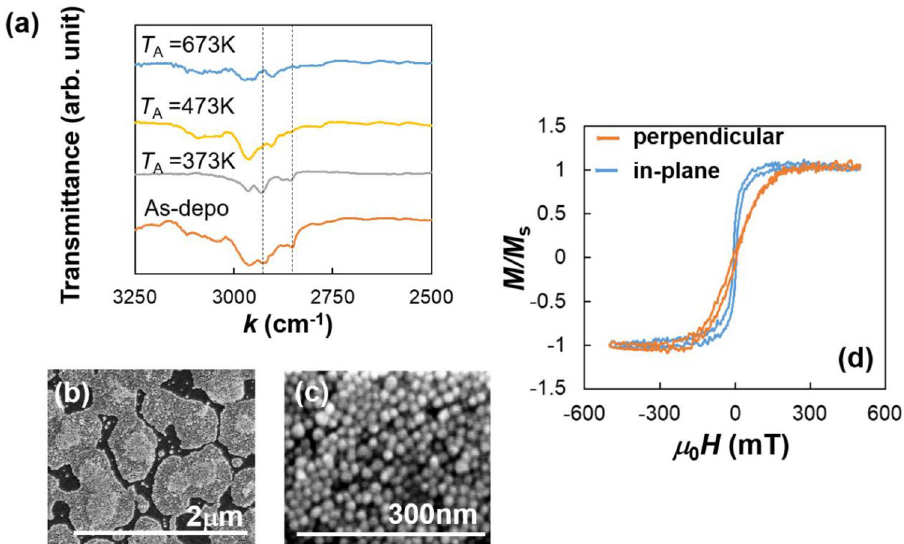
Figure 2. ( a ) FT-IR spectrums of Fe 3 O 4 nanoparticle-assembled films on thermally oxidized Si substrate without or with annealing at T A = 373, 473, and 673 K. Black broken lines indicate k = 2852 and 2922 cm −1 . ( b ), ( c ) SEM images and ( d ) the normalized magnetization M / M S curves of [Pt film/Fe 3 O 4 nanoparticle] 1 film on thermally oxidized Si substrate annealed at T A = 473 K. The orange and blue lines in ( d ) were obtained under perpendicular and in-plane magnetic fields H ,